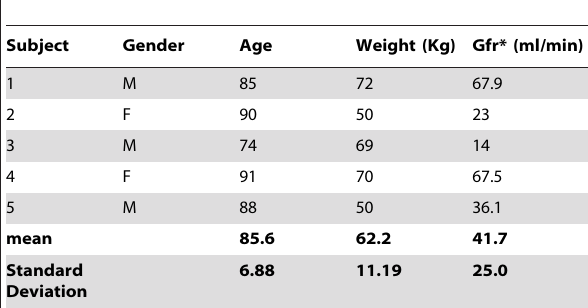
Table 1. Anthropometric characteristics of the studied